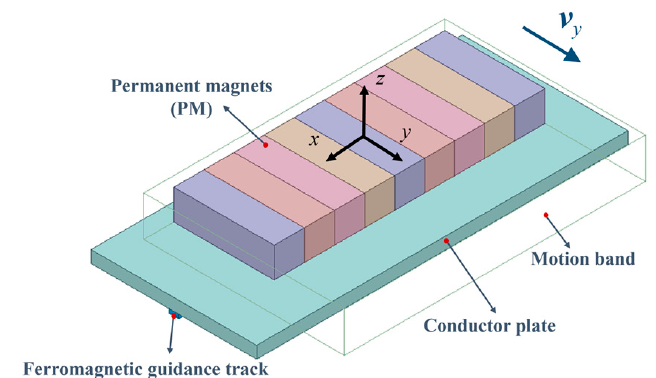
Figure 6. The finite element model of the guidance system.